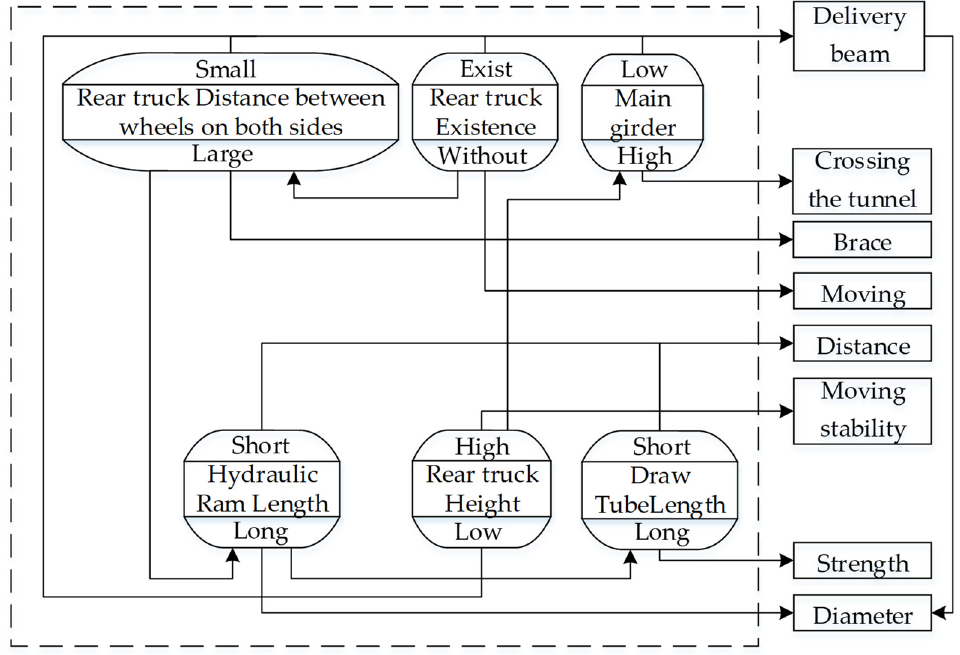
Figure 25. Preliminary solution multi-conflicts parameter network.